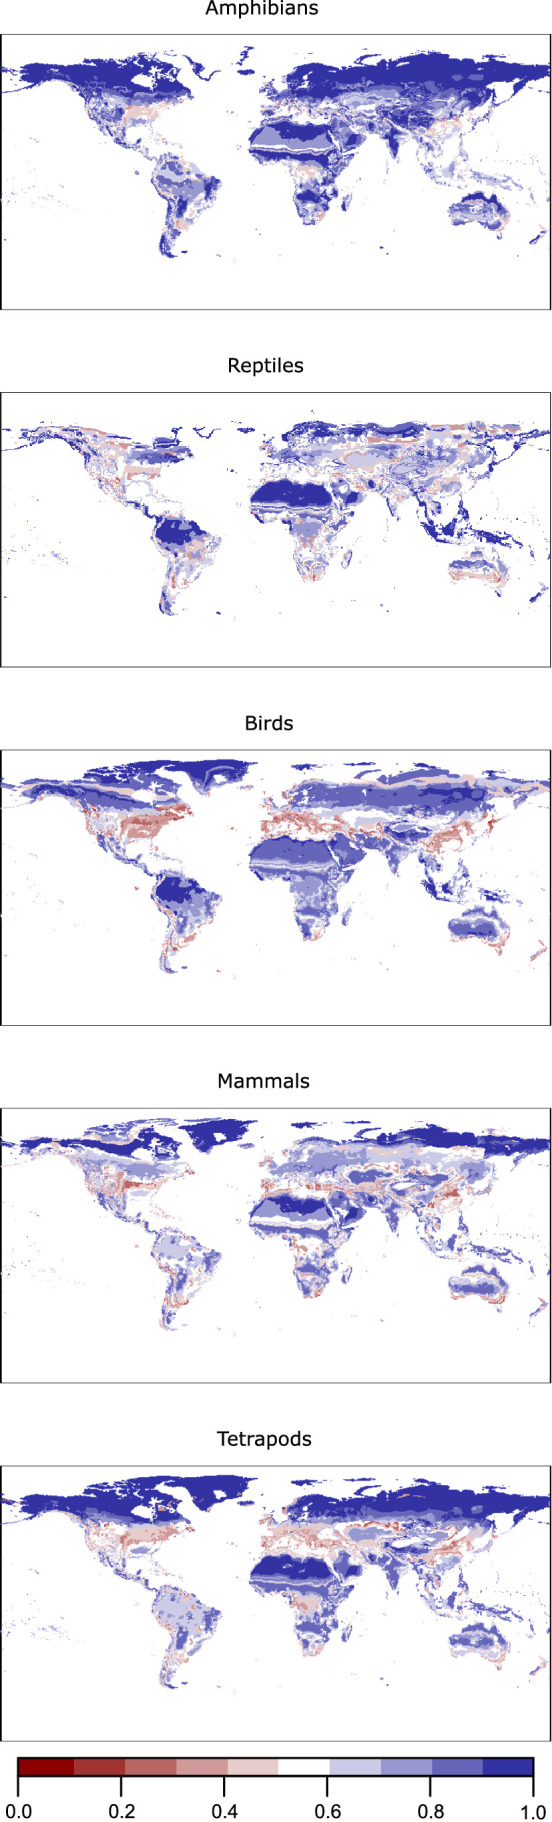
Geographic projection of the specificity of the climatic bins (SP) for the studied groups.